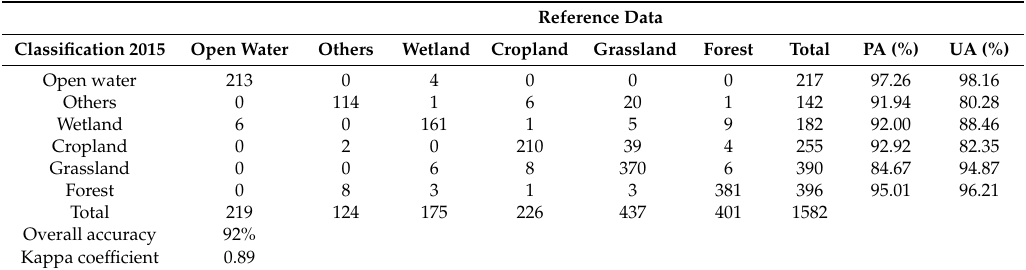
Table 2. Confusion matrix for ca. 2015 with overall accuracy, PA, and